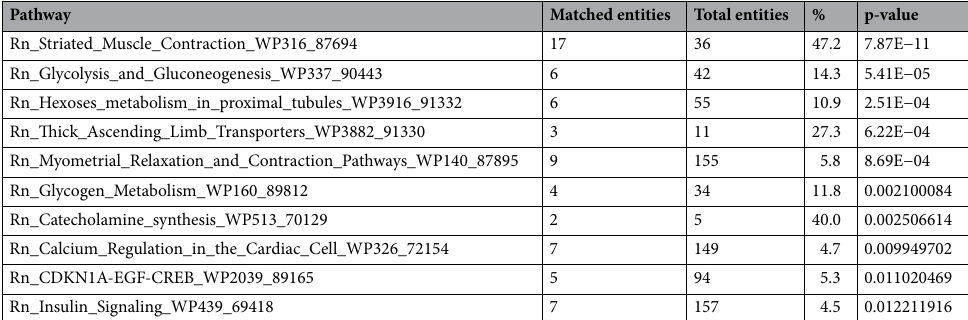
Pathway Matched entities Total entities